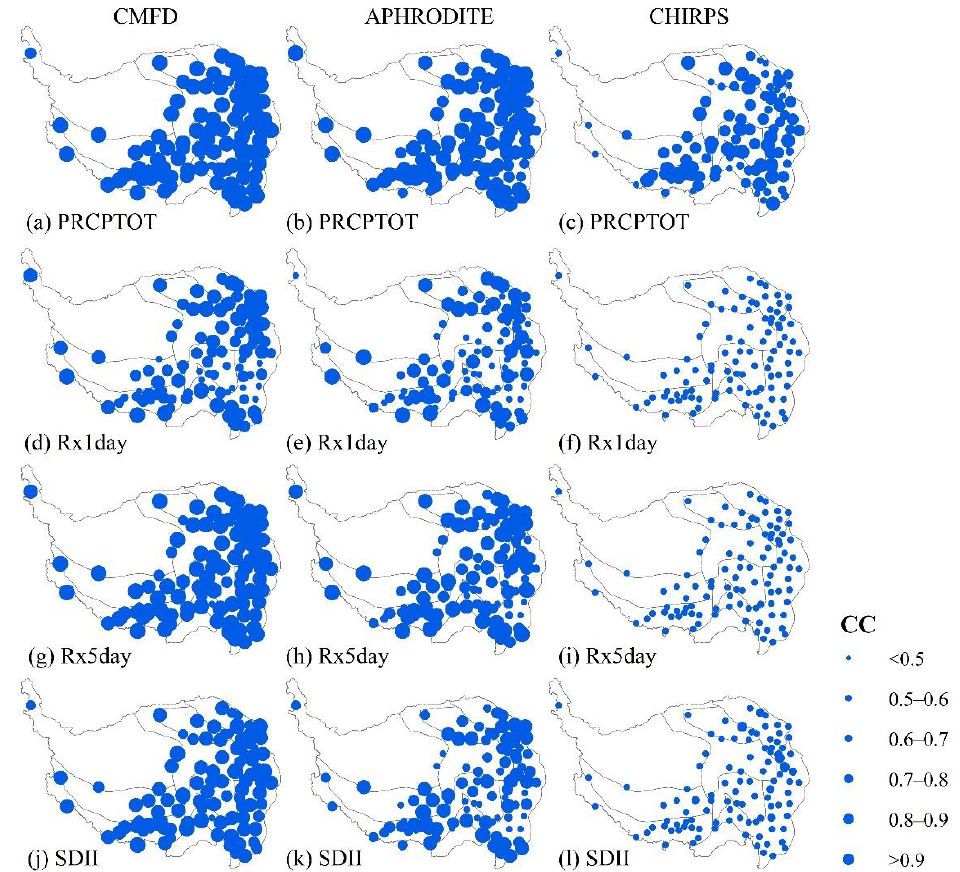
Figure 17. Correlations between gauge-based non-threshold indices PRCPTOT, Rx1day, Rx5day, and SDII, as derived from CMFD, APHRODITE, and CHIRPS from 1981 to 2014.